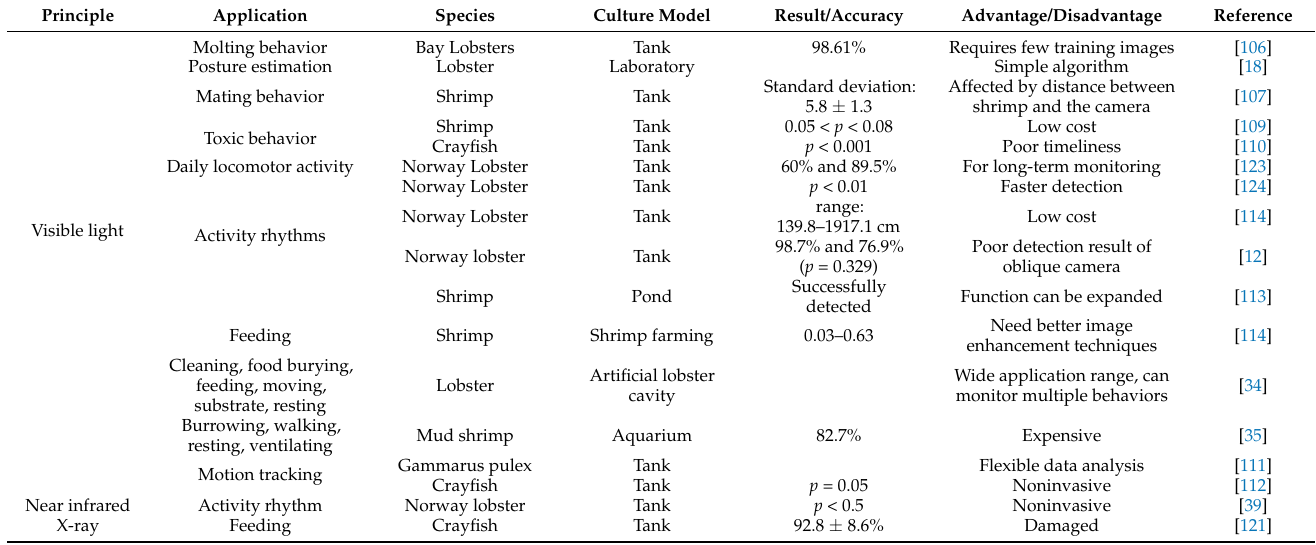
Table 2. Summary of methods based on machine